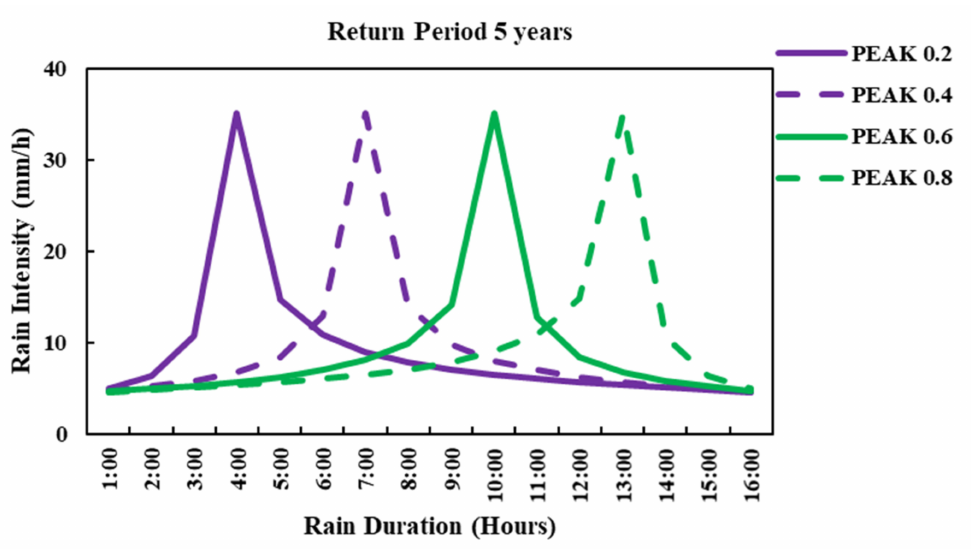
Figure 5. Single peak Chicago design storm by different peak coefficient.